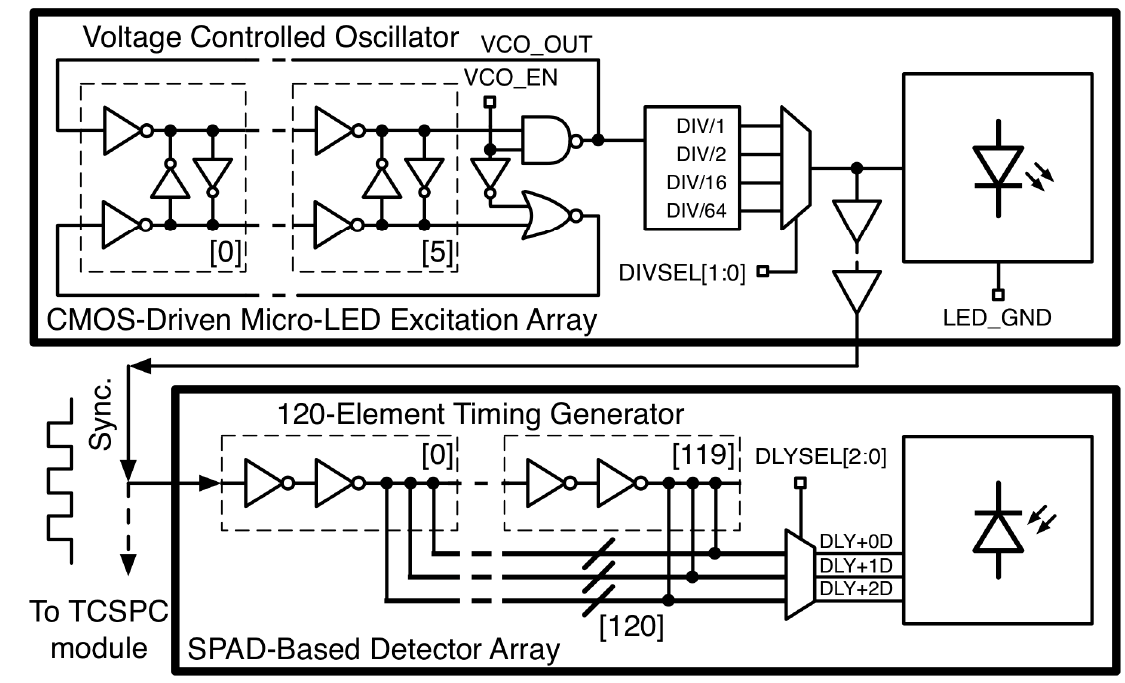
Figure 12. The on-chip VCO provides the square-wave input to the micro-LED driver array and the SPAD time-gate generator